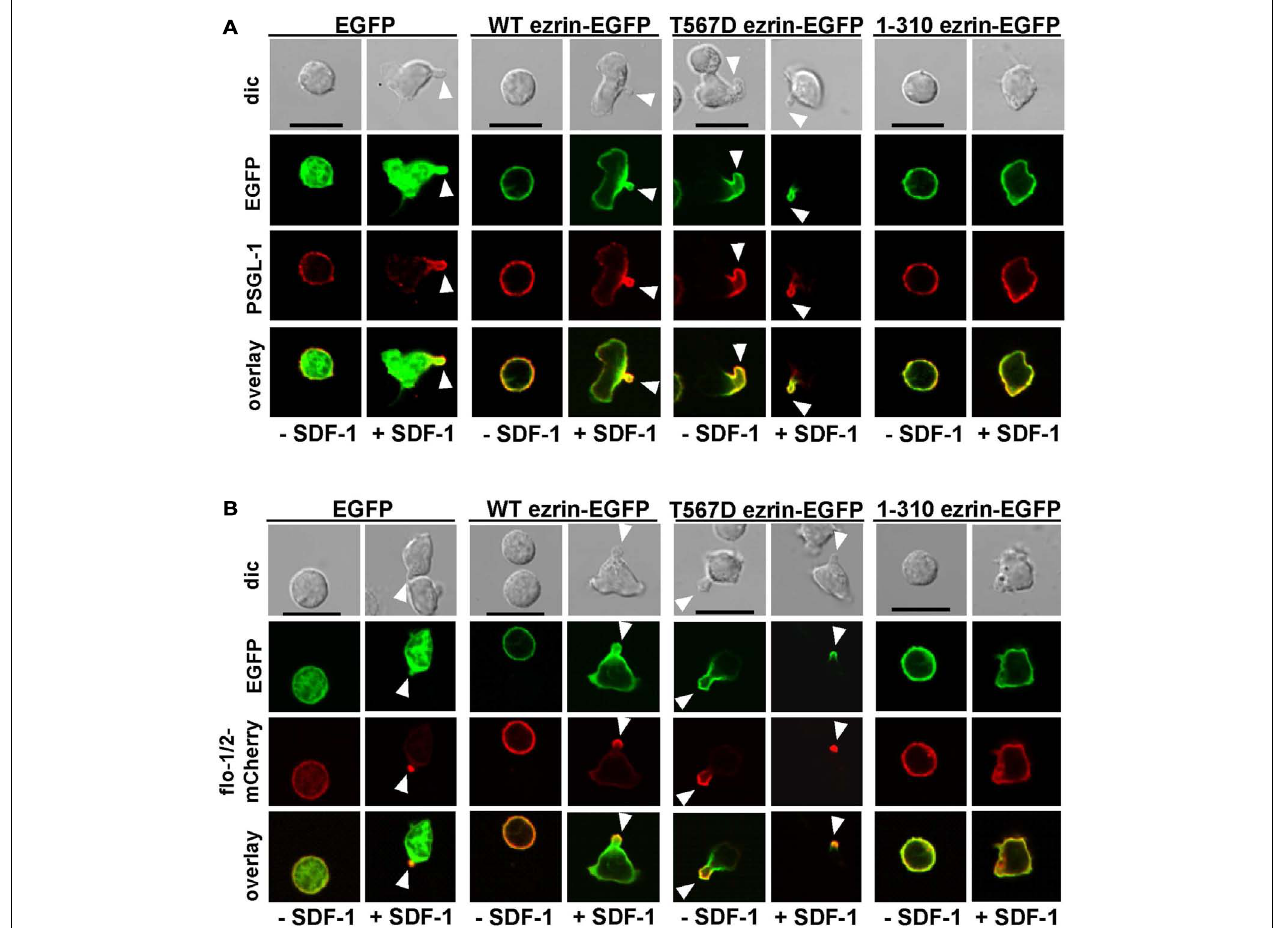
FIGURE 4 | Impact of expression of ezrin constructs on localization of PSGL-1 and flotillins in humanT cells. (A) T cells were transfected either with EGFP, wild type (WT) ezrin-EGFP,T567D ezrin-EGFP, or 1–310 ezrin-EGFP as indicated. Four hours after transfection,T cells were incubated in the absence or presence of SDF-1, as described in the legend of Figure 1D , followed by fixation with PFA, staining for PSGL-1 using a monoclonal antibody and confocal microscopy.